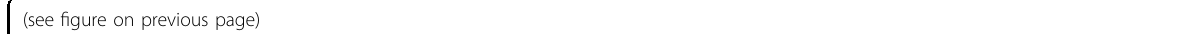
Fig. 5 Gastrin promotes Golgi aggregation and cell polarization at the leading edge in PANC-1 cells through activation of the G α 12/ 13 – RhoA – ROCK signaling pathway. PANC-1 cells were allowed to grow to con fl uence for 24 h and were then pre-treated with G α 12 siRNA, G α 13 siRNA, Rosin, and Y27632 to inhibit expression or activity of G α 12, G α 13, RhoA, and ROCK, respectively. Cells that were scratched with tips were then stimulated with gastrin. Representative images from left to right indicate the Golgi marker protein β -cop (red), cytoskeletal F-actin (green), and cell nucleus (blue). Merged images and wind rose plots of Golgi orientation are shown. Gastrin promoted the reorganization and polarization of the Golgi apparatus at the leading edge of PANC-1 cells facing the detached line; however, a highly disorganized and fragmented Golgi apparatus was distributed in the cytoplasm. Gastrin also induced the polarization of cytoskeletal F-actin accompanied with a non-polarized morphology. G α 12 RNAi, G α 13 RNAi, Rosin, and Y27632 pre-treatment blocked the polarization of the Golgi and F-actin that was induced by gastrin. Wind rose plots indicate the Golgi orientation in cells, and only the gastrin treatment group restored proper cell polarity and Golgi